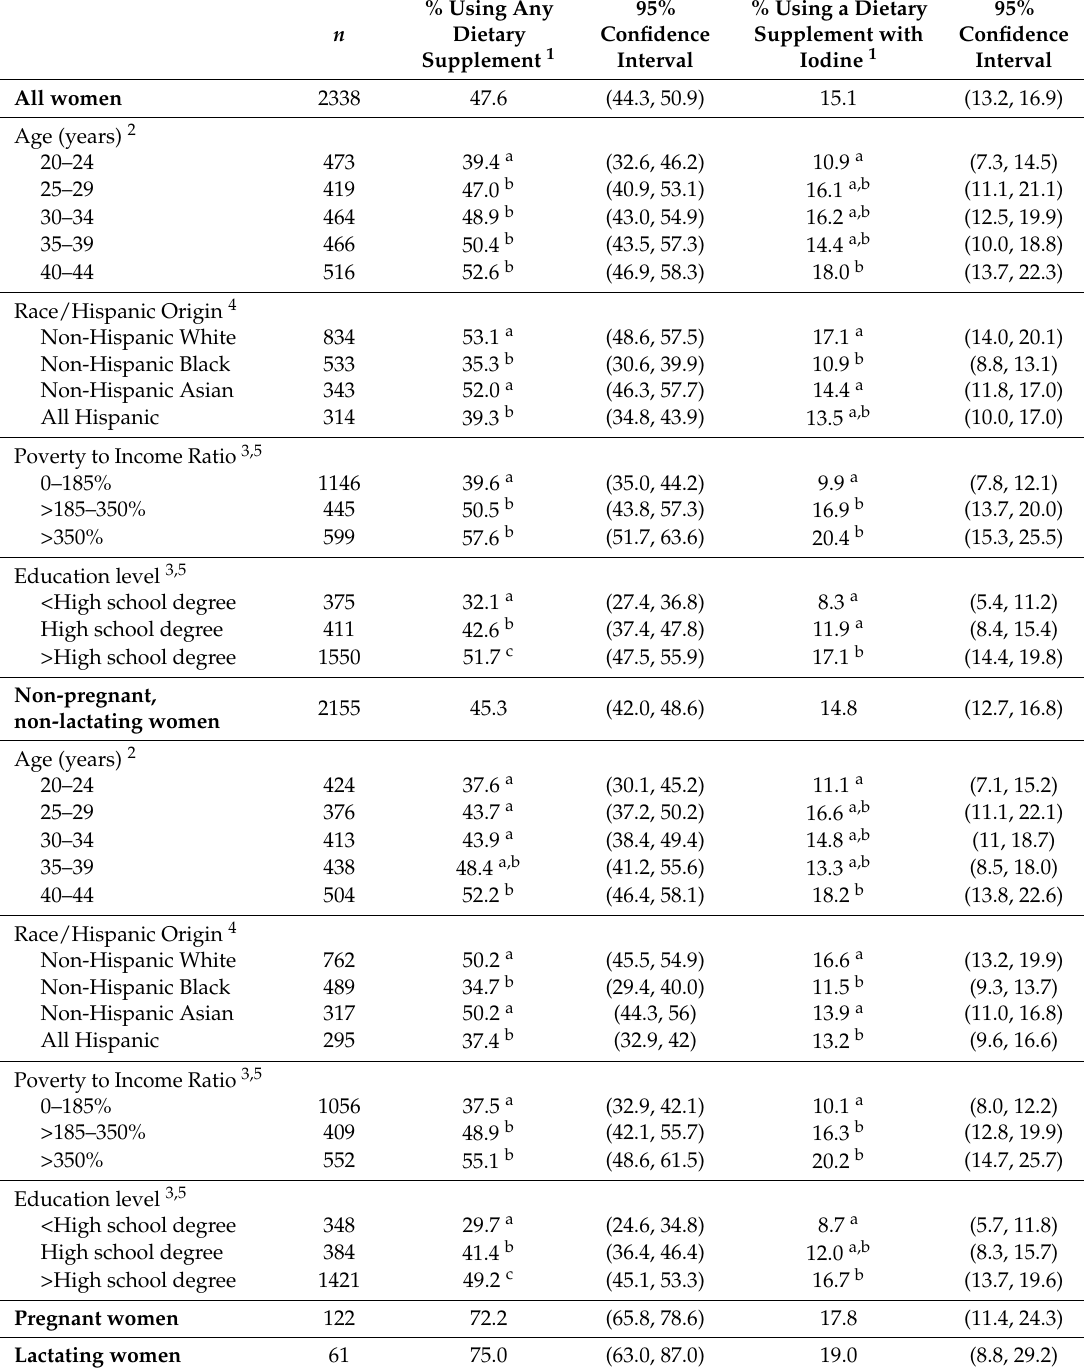
Table 1. Prevalence of supplement use and iodine-containing supplement use among women